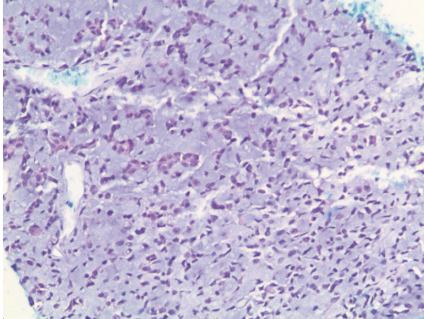
Figure 3: HE staining of tumor showing highly cellular epithelial cells with fascicles of short spindle